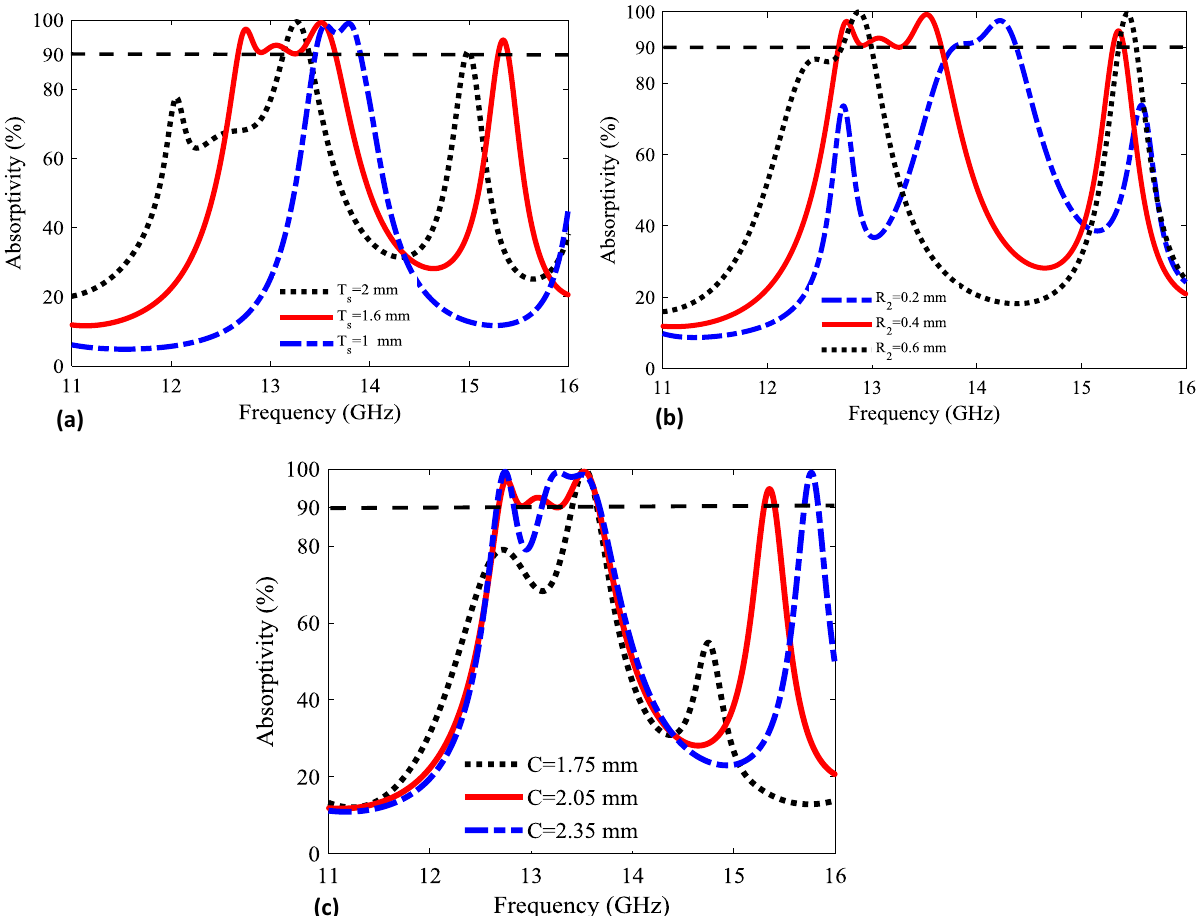
Figure 6. Absorptivity spectrum for different geometrical parameters including ( a ) thickness of substrate T s , ( b ) radius of inner ring R 2 and ( c ) split ring gap size C . The schematic illustration of all such geometrical parameters in provided in Fig.